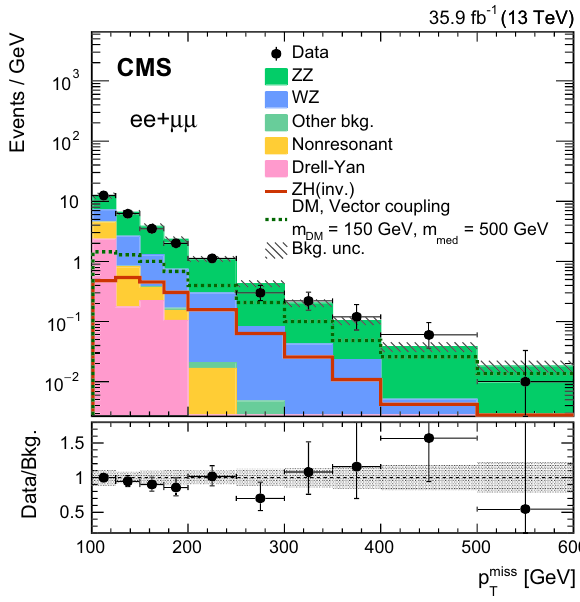
Fig. 4 Distribution of the p miss in the combination of the ee and μμ T channels after the full selection. The last bin also includes any events > 600GeV. The uncertainty band includes both statistical with p miss bin for the sum of back- T T andsystematiccomponents.TheZH ( inv. ) signalnormalizationassumes SM production rates and the branching fraction B ( H → inv. ) = 1 classifier) is taken into account by varying the value of the quantity associated with the uncertainty, and observing the . resulting variations in the individual bins of p miss T In addition to all of the sources of systematic uncertainty -based analysis, the following systematic uncer- in the p miss T tainties in the BDT-based analysis affect the BDT classifier shape. The most important sources of uncertainty in the BDT uncer- classifier shape are the lepton energy scale and p miss T